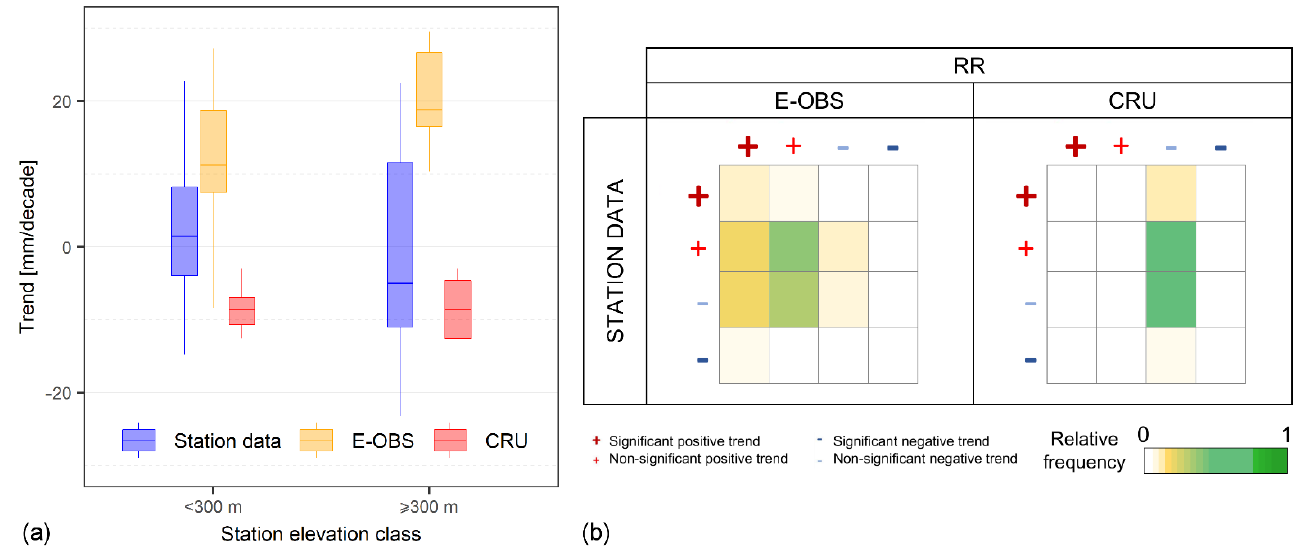
Figure 3. Results of trend analysis for total annual precipitation (RR) using the three considered databases: ( a ) calculated trend rates; and ( b ) normalized contingency matrices for detected trend signs.